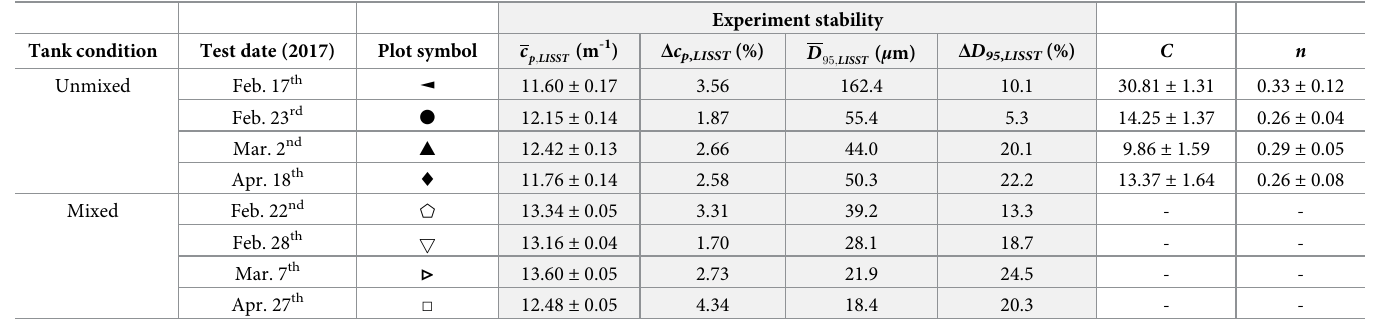
Table 3. Summary of experimental tests with floc population stability and resulting strength